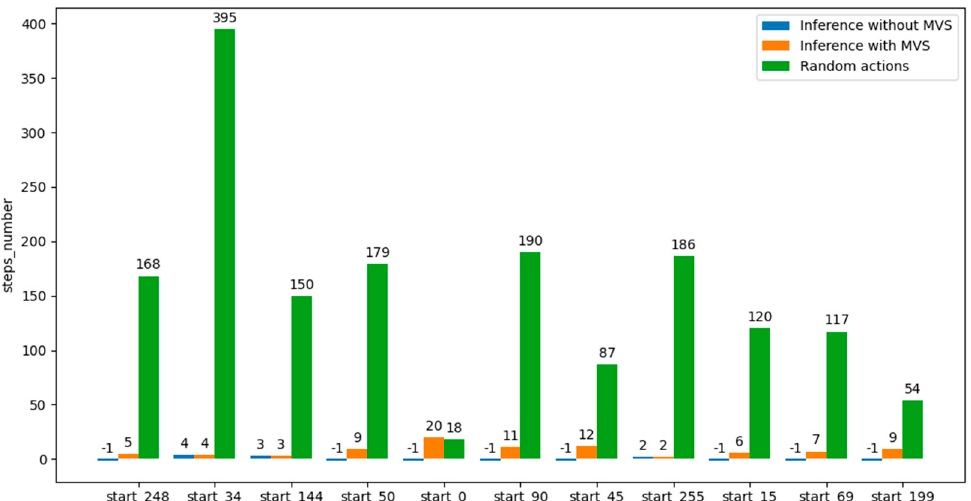
Figure 7. Performance graph of whether or not the MVS mechanism was applied at the inference stage for an agent trained using the third reward scheme.